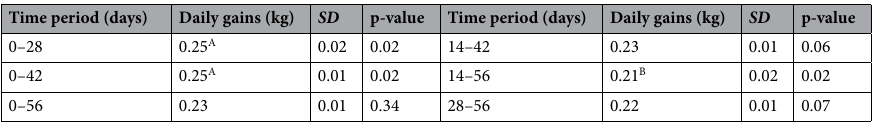
Table 2. Daily mass gains in lambs during the rearing period up to 56 days of age (kg). p < 0.05—A, B, C; p < 0.01—a, b,